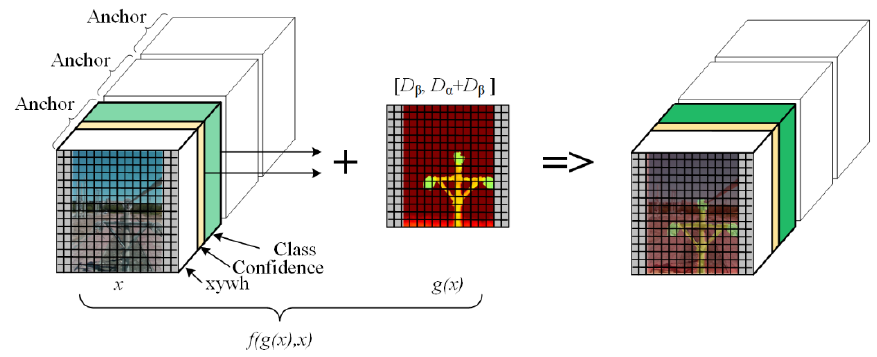
Figure 12. Principle of depth-attention mechanism.